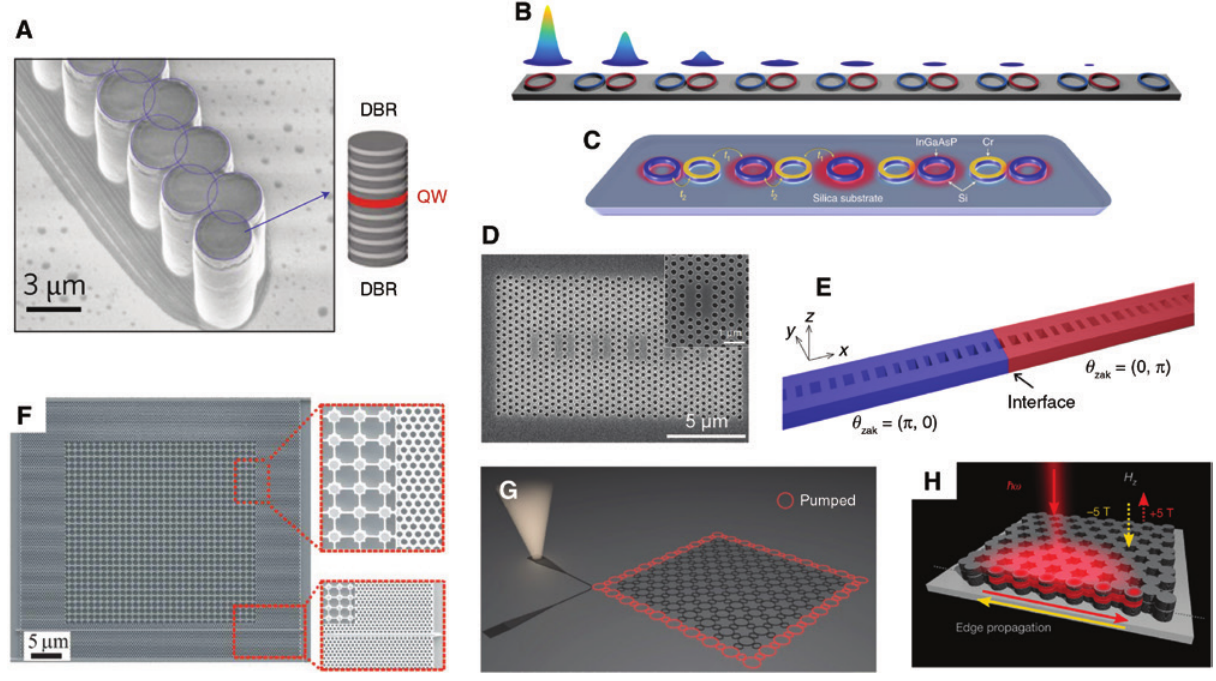
Figure 1: Topological laser structures. 1D arrays of (A) micropillar cavities, (B, C) microring cavities, and (D) photonic crystal nanocavities. (E) 1D photonic crystal nanobeam with a topological disorder. (F) 2D photonic crystal forming a microring resonator with a 1D edge channel. 2D arrays of (G) microring resonators